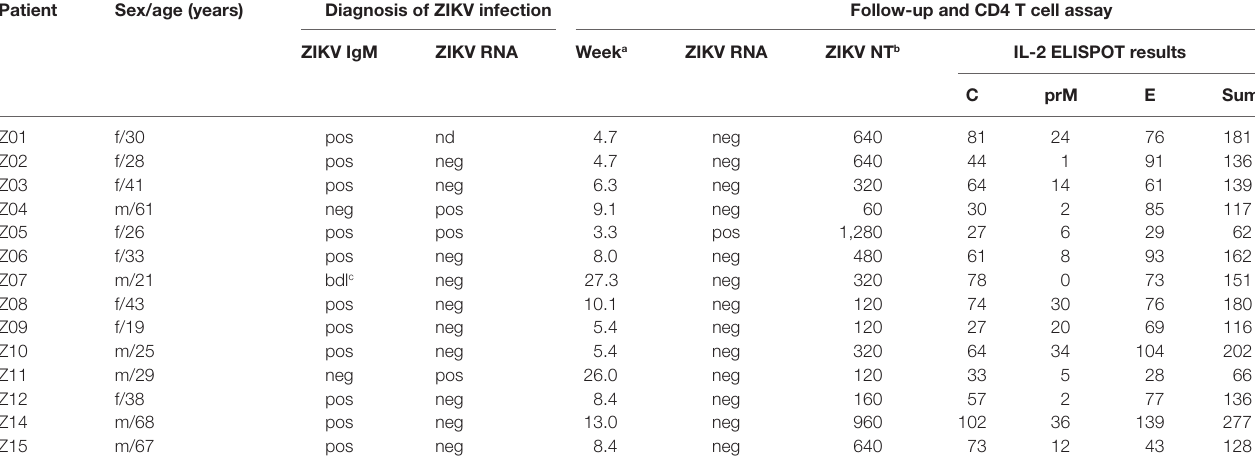
TaBle 1 | Characteristics of study participants.